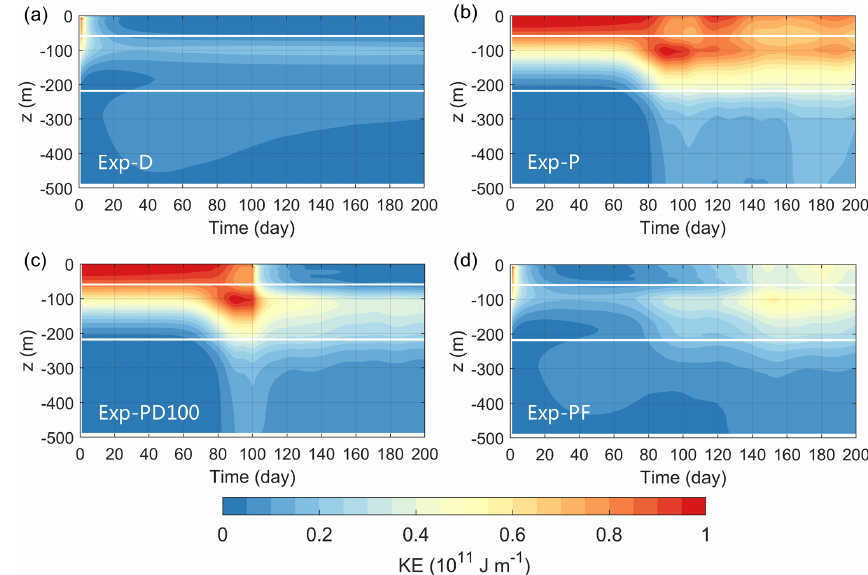
Figure 9. Time–depth plot of the horizontal integral of KE from the four sensitivity experiments. The white lines in each panel mark the depths of the two stratification peaks ( − 59 and − 218m).